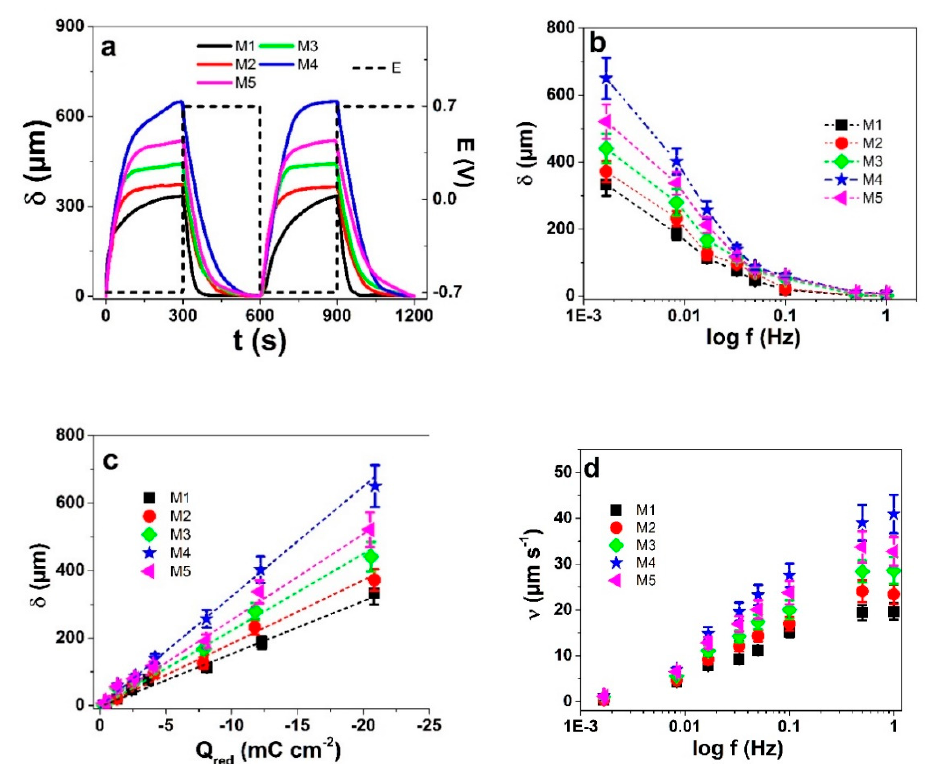
Figure 4. Square wave potential step (16.7 mHz, ± 0.7 V, dotted line) measurements in bis(trifluoromethane)sulfonimide lithium salt (LiTFSI-aq) electrolyte. ( a ) Two subsequent cycles (4th to 5th) of displacement δ response of membrane actuators M1 (black line) and patterned M2 (red), M3 (green), M4 (blue) and M5 (pink). ( b ) Displacements against log frequency of M1 ( ■ ), M2 ( ● ), M3 ( ♦ ), M4 ( ★ ) and M5 ( ◄ ); and ( c ) displacements against charge density upon reduction. ( d ) The actuation speed ν of M1–M5-type membrane actuators against log frequency. The dashed line in ( c ) represents the linear fit and is shown here only for orientations.